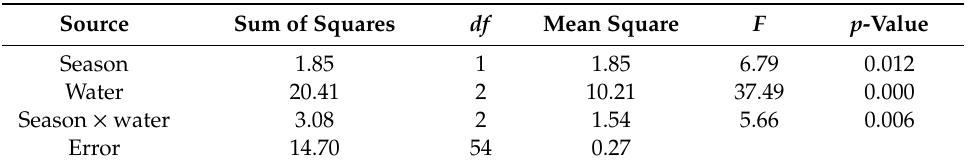
Table 2. ANOVA table of the final LAI model (non-significant parts were iteratively excluded from three-way full-factorial model including season, water and